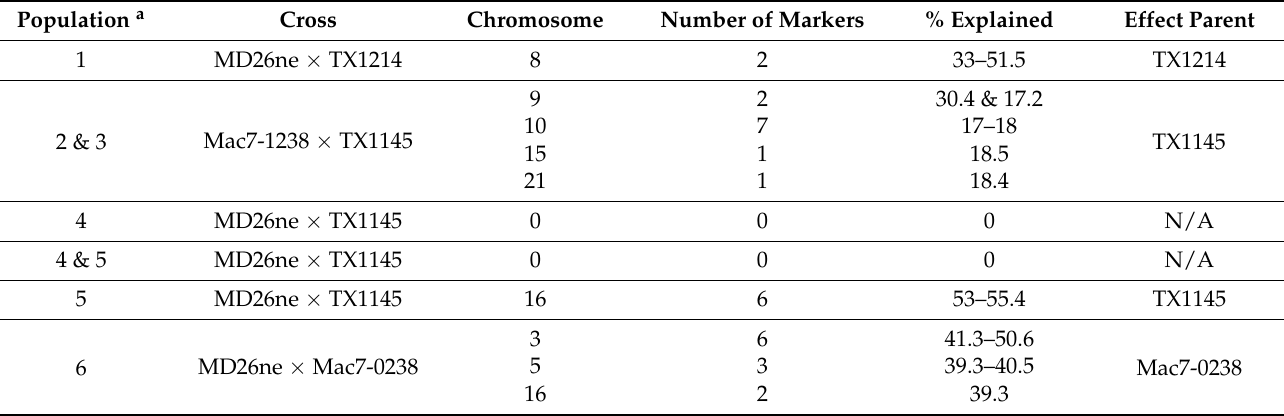
Table 2. Quantitative Trait Loci identified for each of the genetic mapping